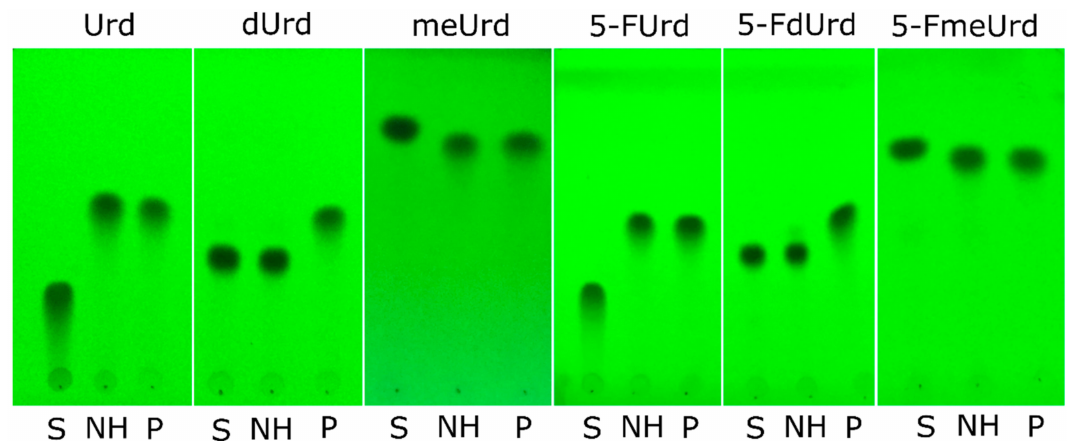
Figure 5. An example of Thin-Layer Chromatography (TLC) plates of substrates (S, also indicated above the plate), enzymatic RK9NH reactions (NH) and product standards (P): uracil is formed when uridine and 2 (cid:48) - O -methyluridine are used as substrates; 5-fluorouracil is formed, when 5-fluorouridine, 5-fluoro-2 (cid:48) -deoxyuridine and 5-fluoro-2 (cid:48) - O -methyluridine are used as substrates. S: substrate, NH: RK9 nucleoside hydrolase enzymatic reaction, P: product standards (uracil or 5-fluorouracil), Urd: uridine, dUrd: 2 (cid:48) -deoxyuridine, meUrd: 2 (cid:48) - O -methyluridine, 5-FUrd: 5-fluorouridine, 5-FdUrd: